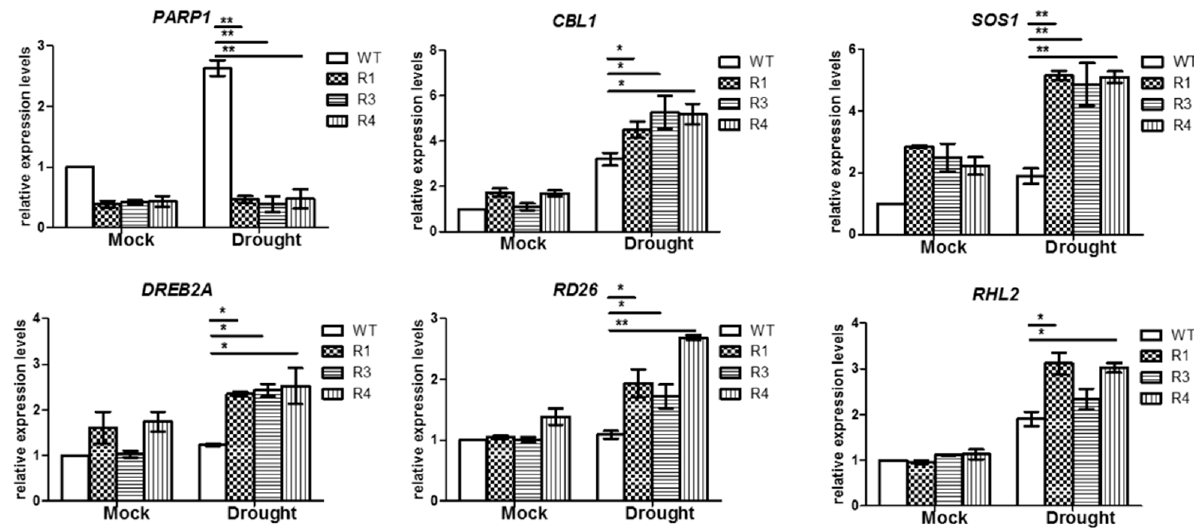
Figure 6. Expression analysis of stress-related genes in B. rapa under drought treatment. RD26: RESPONSIVE TO DESICCATION 26; SOS1: STRESS OVERLY SENSITIVE 1; CBL1: CALCINEURIN B-LIKE PROTEIN 1; RHL2: ROOT HAIRLESS 2; DREB2A: DEHYDRATION RESPONSIVE ELEMENT- BINDING PROTEIN2A . (** p < 0.01, * p <